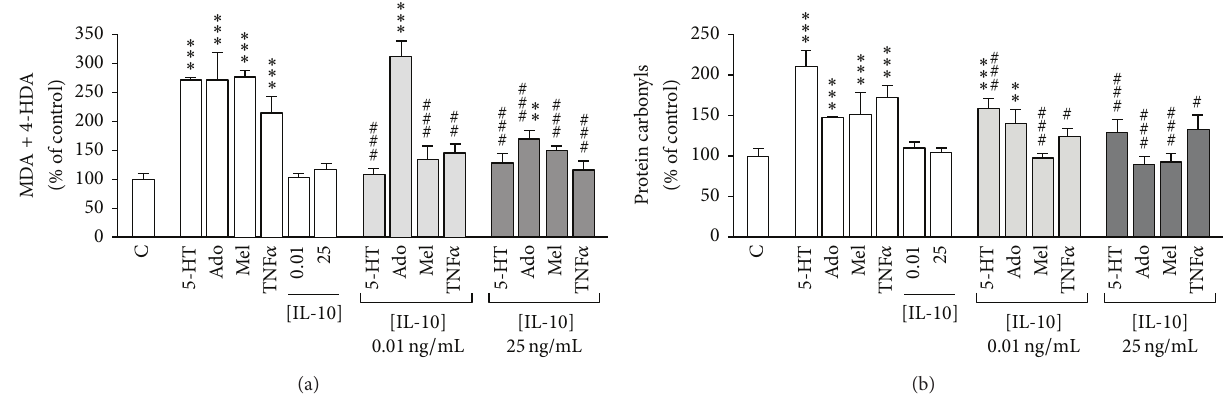
Figure 1: Effect of 5-HT, adenosine, melatonin, TNF 𝛼 , and/or IL-10 on lipid peroxidation (a) and protein oxidation (b). Caco-2 cells were treated throughout the course of one day with either 5-HT 100 𝜇 M, adenosine (Ado) 100 𝜇 M, melatonin (Mel) 5mM, TNF 𝛼 5ng/mL, or IL-10 at two concentrations, 0.01 or 25ng/mL. Results were expressed as the percentages of the control value (100%) and were indicated as the mean ± SE of five independent experiments. ∗∗ 𝑃 < 0.01 , and ∗∗∗ 𝑃 < 0.001 , compared with control (C); # 𝑃 < 0.05 , ## 𝑃 < 0.01 , and ### 𝑃 < 0.001 compared with the corresponding condition of treatment without